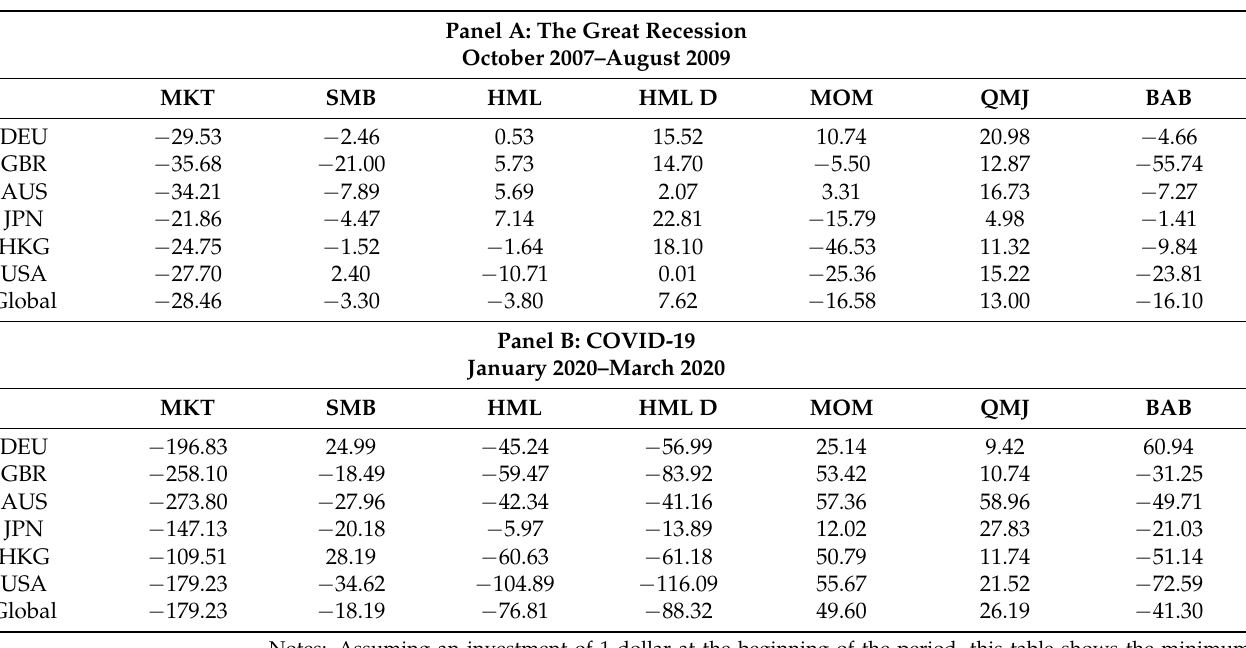
Table 6. Annualized Minimum Cumulative Return. Panel A: The Great Recession